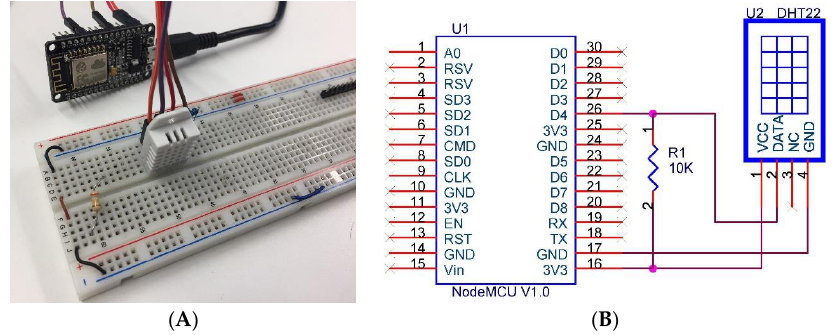
Figure 3. Prototype of the temperature acquisition system. ( A ) shows the prototype and ( B ) shows the connections.